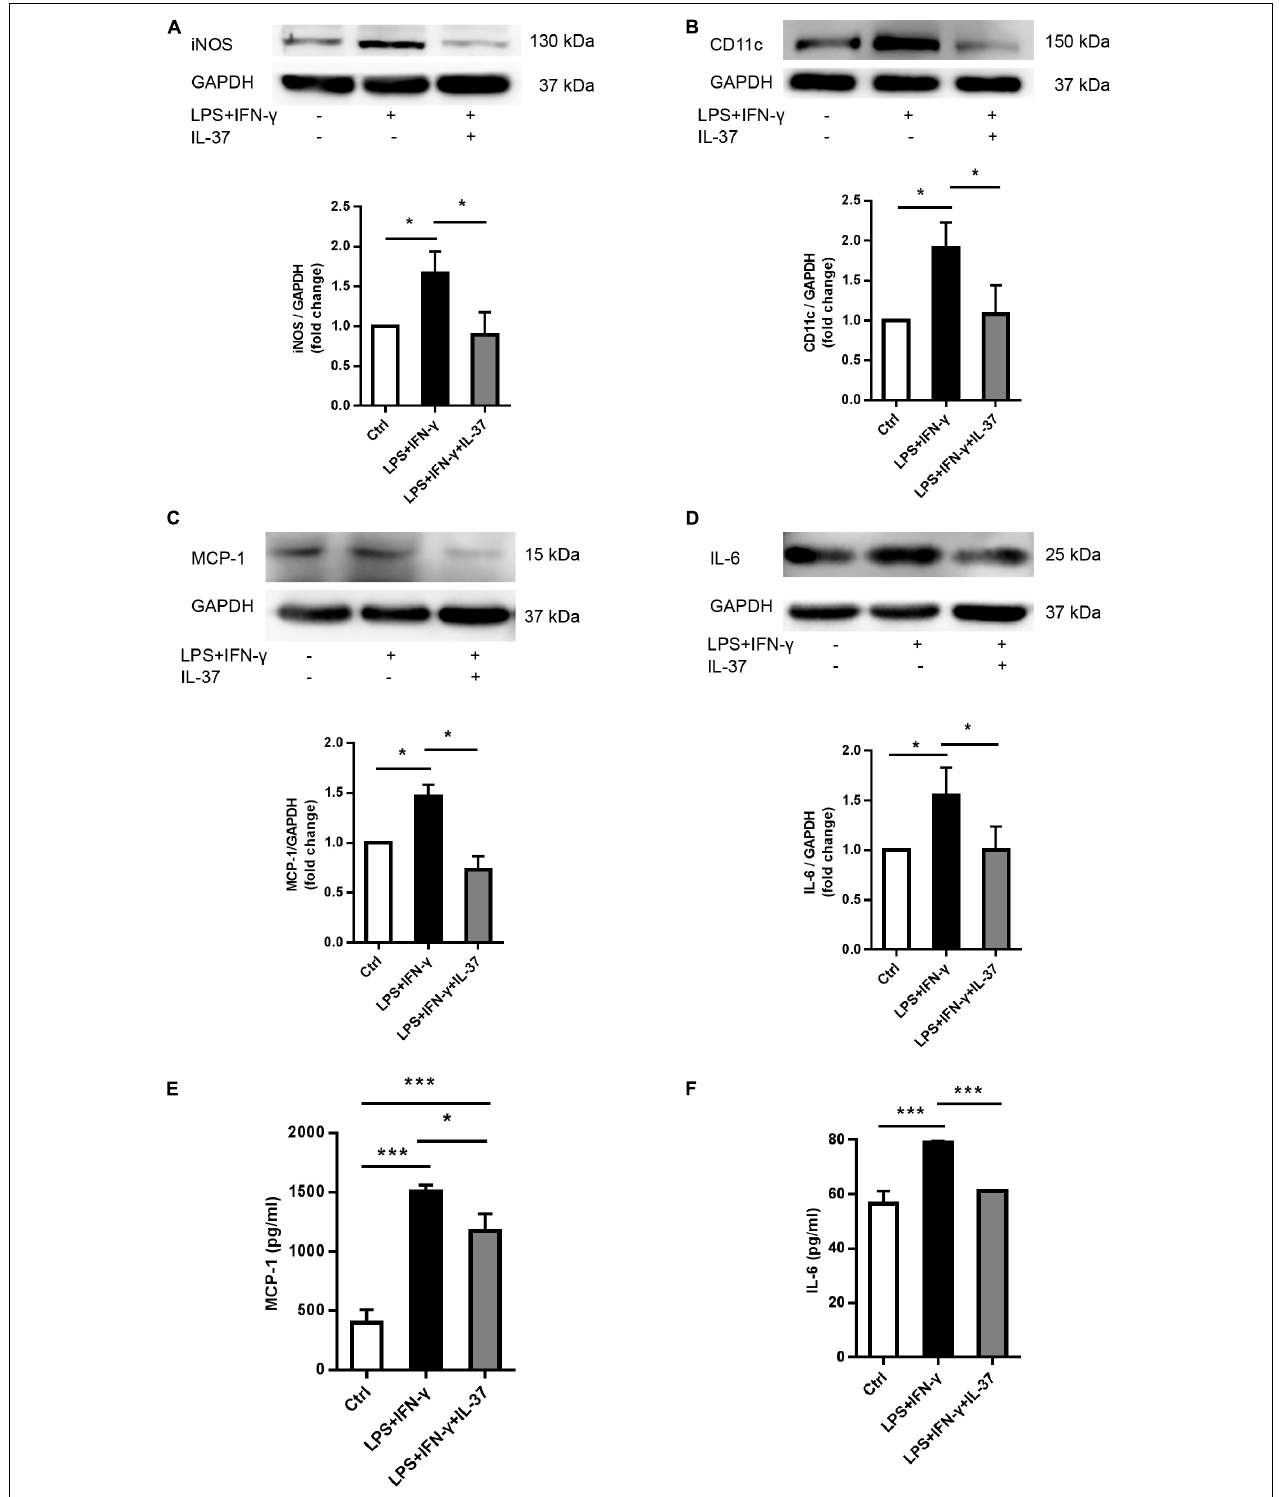
FIGURE 2 | IL-37 suppresses M1 macrophage polarization and pro-inflammatory cytokines secretion. PMA-treated THP-1 cells were treated with LPS (100 ng/ml) and IFN- γ (20 ng/ml) in the presence or absence of recombinant IL-37 (0.1 ng/ml). (A,B) Representative immunoblots and densitometric data show that IL-37 inhibits iNOS and CD11c expression; n = 3, * P < 0.05. (C,D) Representative immunoblots and densitometric data show that IL-37 down-regulates MCP-1 and IL-6 expression; n = 3, * P < 0.05. (E,F) The ELISA data show that IL-37 down-regulates MCP-1 and IL-6 secretion; n = 3, * P < 0.05, *** P < 0.001.